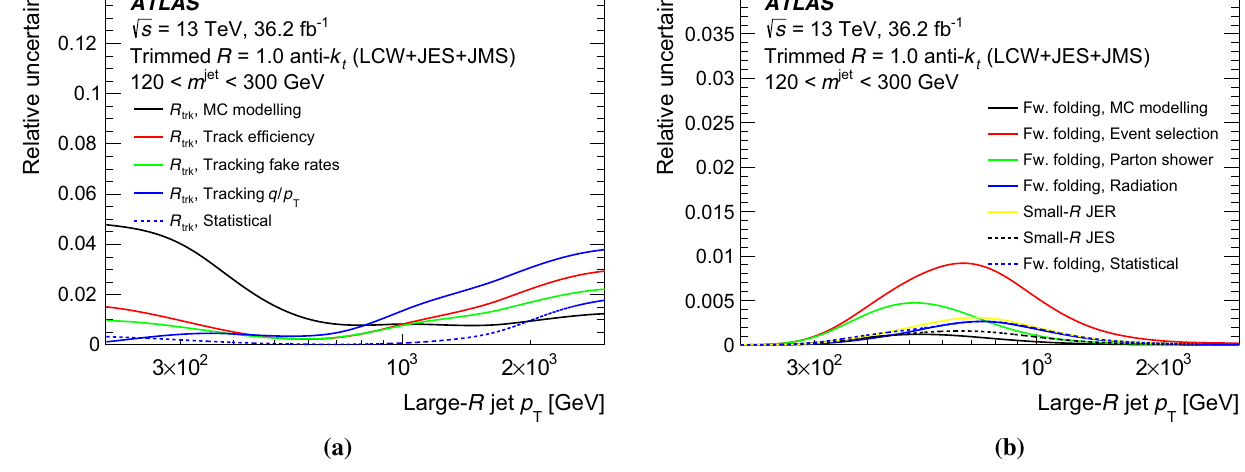
the uncertainty introduced by a given nuisance parameter in combina- tion, incorporating the weight of the method from which it originates. This weight is dominated at high p T by the R trk method. The lines shown are smoothed using a sliding Gaussian